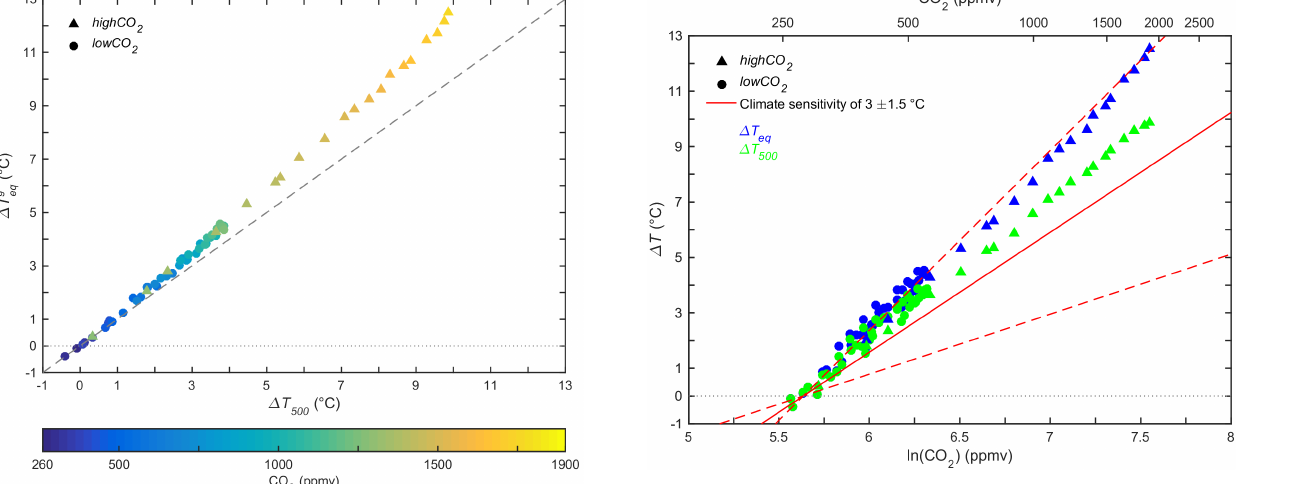
Figure 6. Equilibrated global mean annual change in SAT ( (cid:49)T ◦ C) estimated using the methodology of Gregory et al. (2004) against global mean annual change in SAT ( (cid:49)T 500 , ◦ C) at year 500 (average of final 50 years) for the low CO 2 (circles) and high CO 2 (triangles) modice ensembles. The colours of the points indicate the CO 2 concentration of the experiment, from low (blue) to high (yel- low). The 1:1 line (dashed) is included for reference. SAT is shown as an anomaly compared with the pre-industrial control simulation.